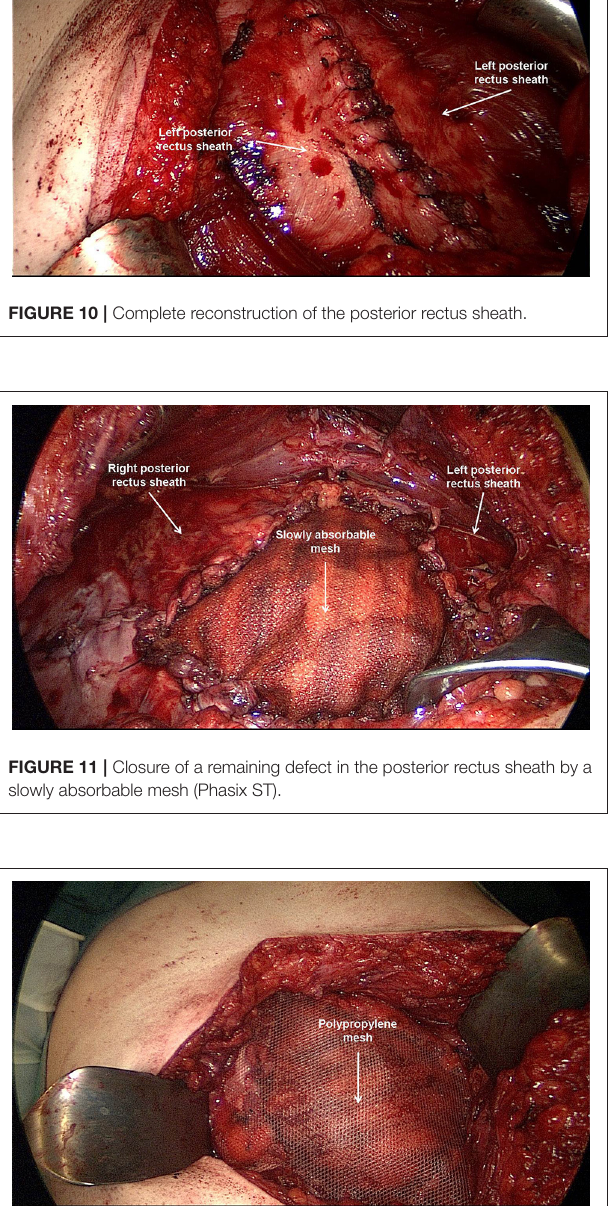
FIGURE 9 | Closure of the posterior rectus sheath caudally.